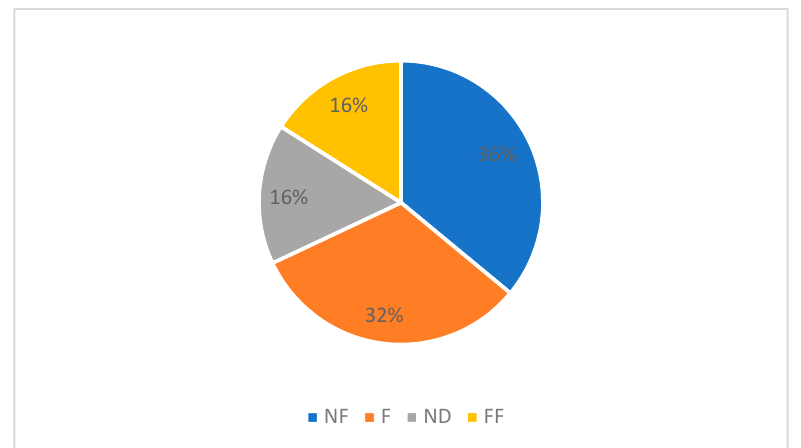
Figure 9. Results of the experiments in the period after lunch for the evening circadian chrono-type.